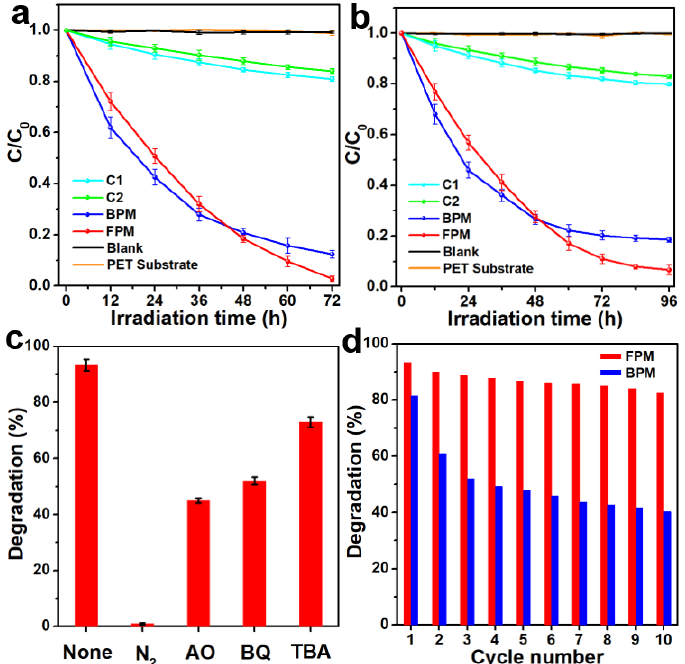
Figure 2. Photocatalytic performance: ( a ) MO degradation; ( b ) Tch degradation; ( c ) Tch degradation of the FPM under different kinds of ROS sacrificial agents; ( d ) cycle test of Tch degradation with each cycle for four days.